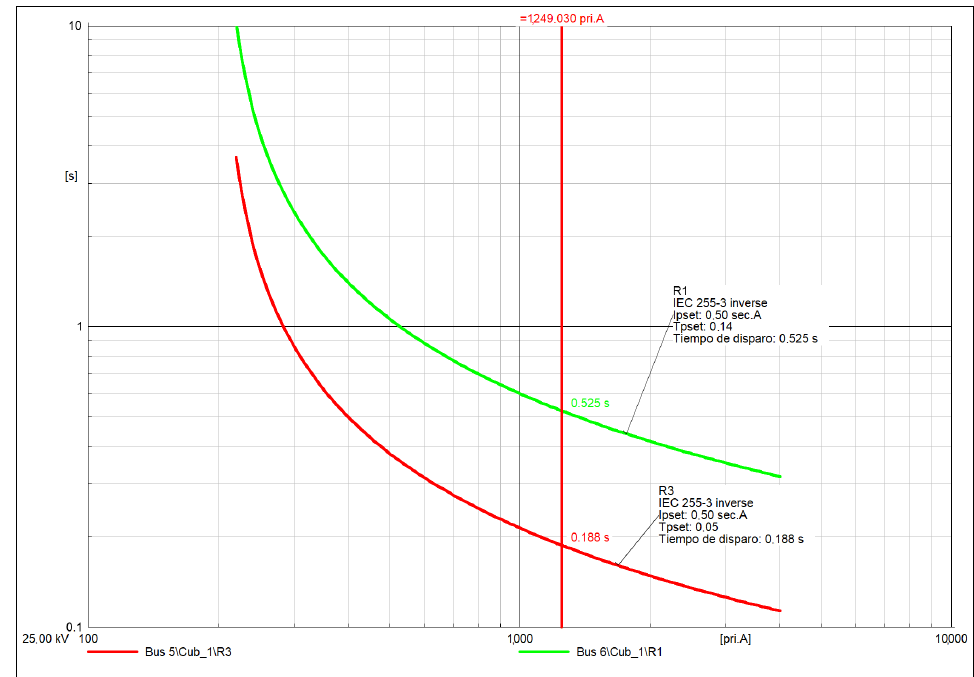
Figure 9. Coordination curve R1–R3 line fault DL-4 scenario BC DG.